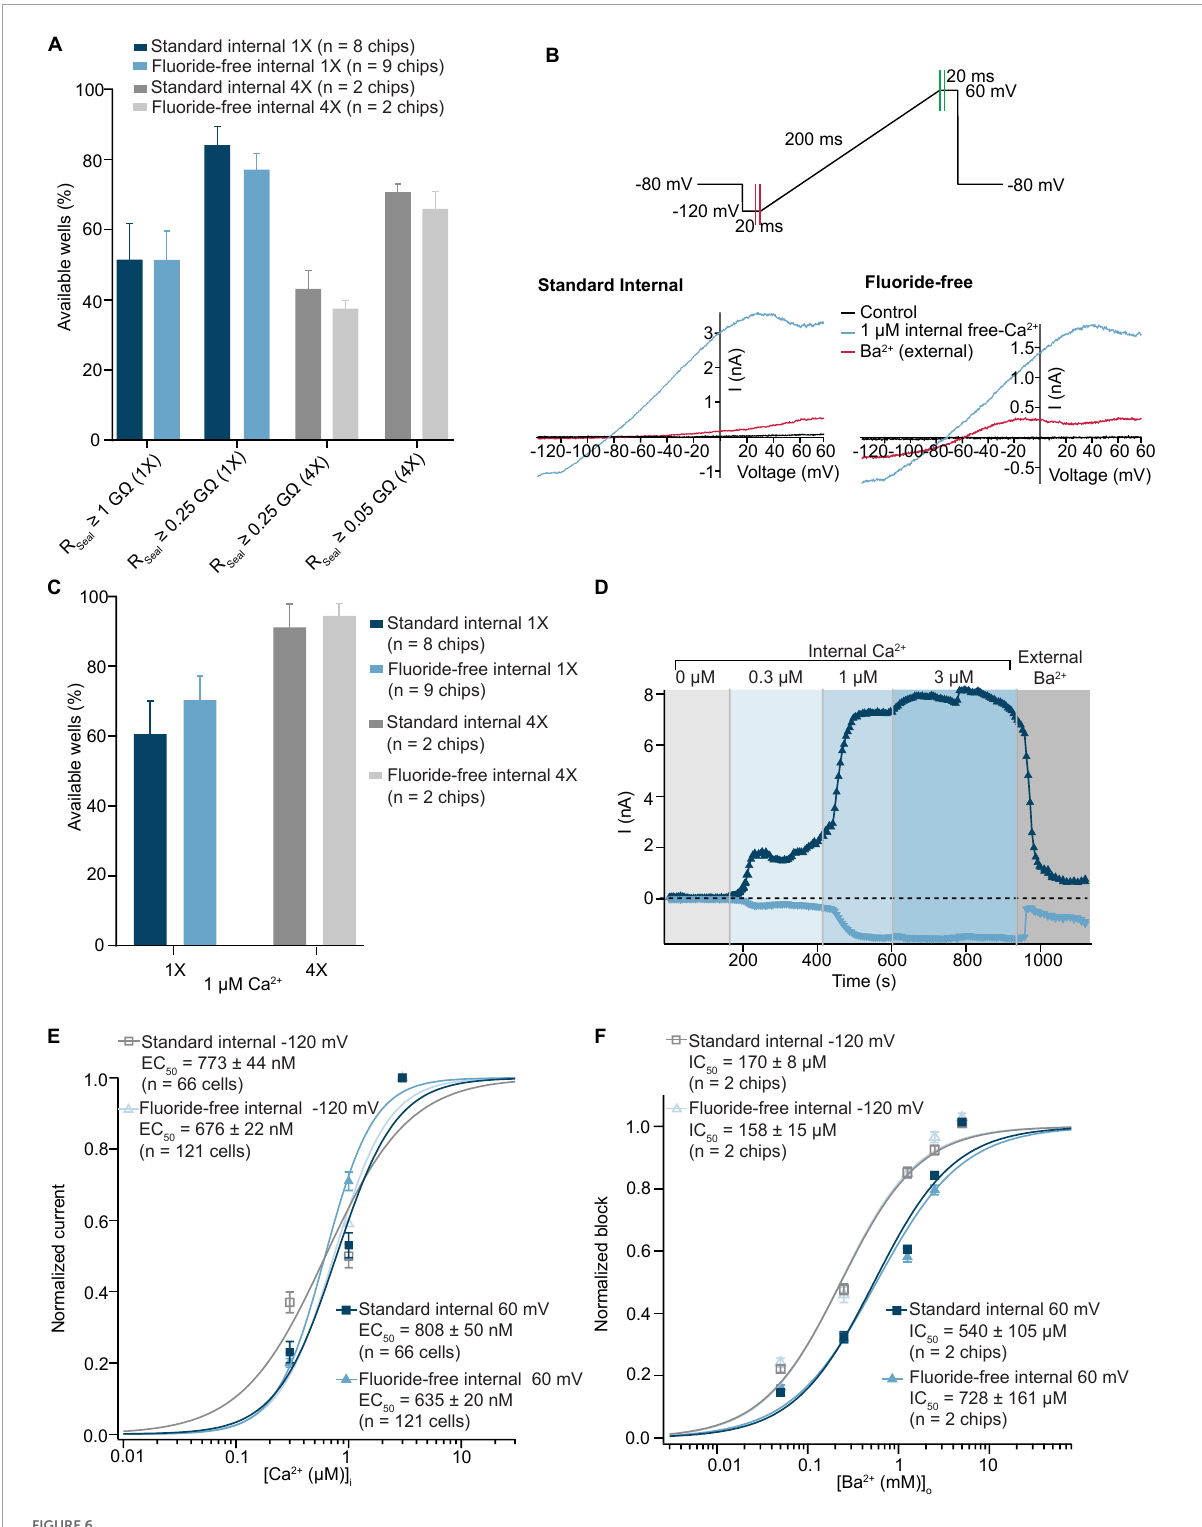
FIGURE6 Activation by internal free Ca 2 + of K Ca 3.1 recorded in standard and fluoride-free internal solution. (A) CHO cells expressing K Ca 3.1 were captured with almost 50% success rate for R Seal ≥ 1 G (cid:127) with standard and in fluoride-free internal solution (left). If a QC cutoff of R Seal ≥ 0.25 G (cid:127) was used, the success rate was increased in both conditions (right). Similar success rates were also achieved with multi-hole